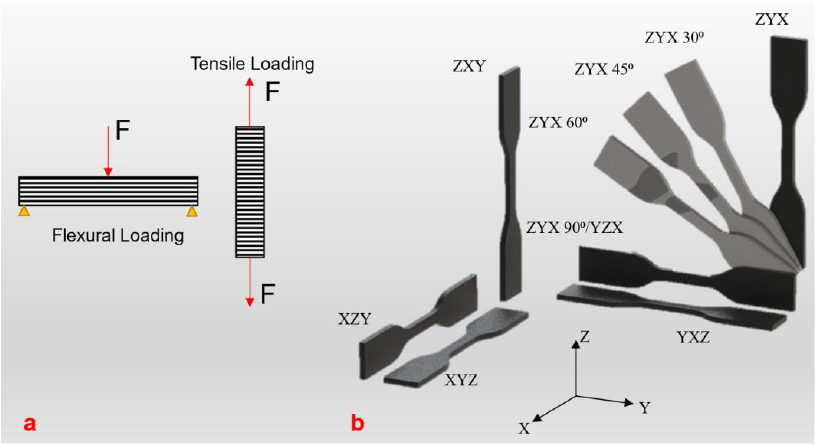
Figure 8. ( a ) Illustration of flexural and tensile loading and ( b ) definition of specimen orientation, redrawn from [16].